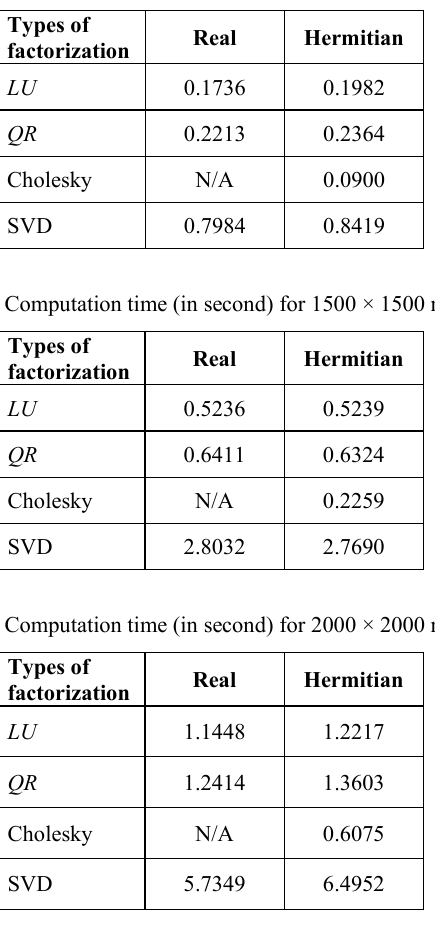
Table 4. Computation time (in second) for 1000 × 1000 matrix.